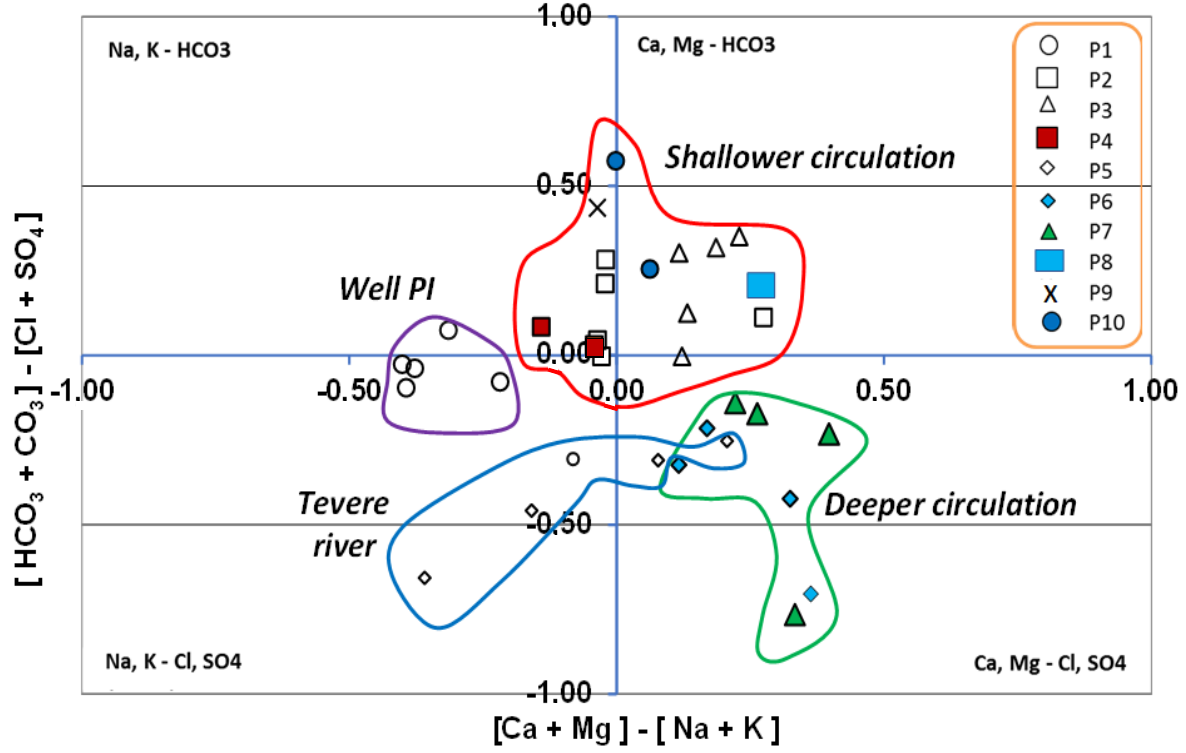
Figure 5. Chada diagram with composition of groundwater sampled during the year 2016.